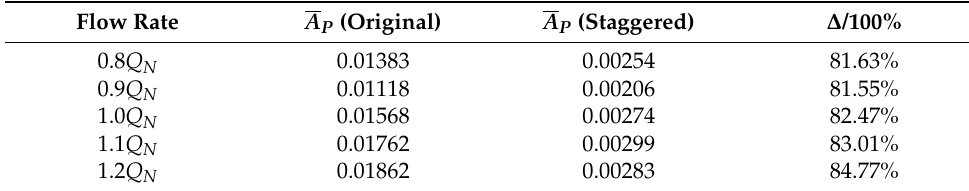
Figure 7. Comparison of f bpf amplitude of pressure pulsation under 0.8 Q N – 1.2 Q N . Table 3. Average values and variation values of f bpf amplitude.